Question: Summarize what this figure shows in one sentence.
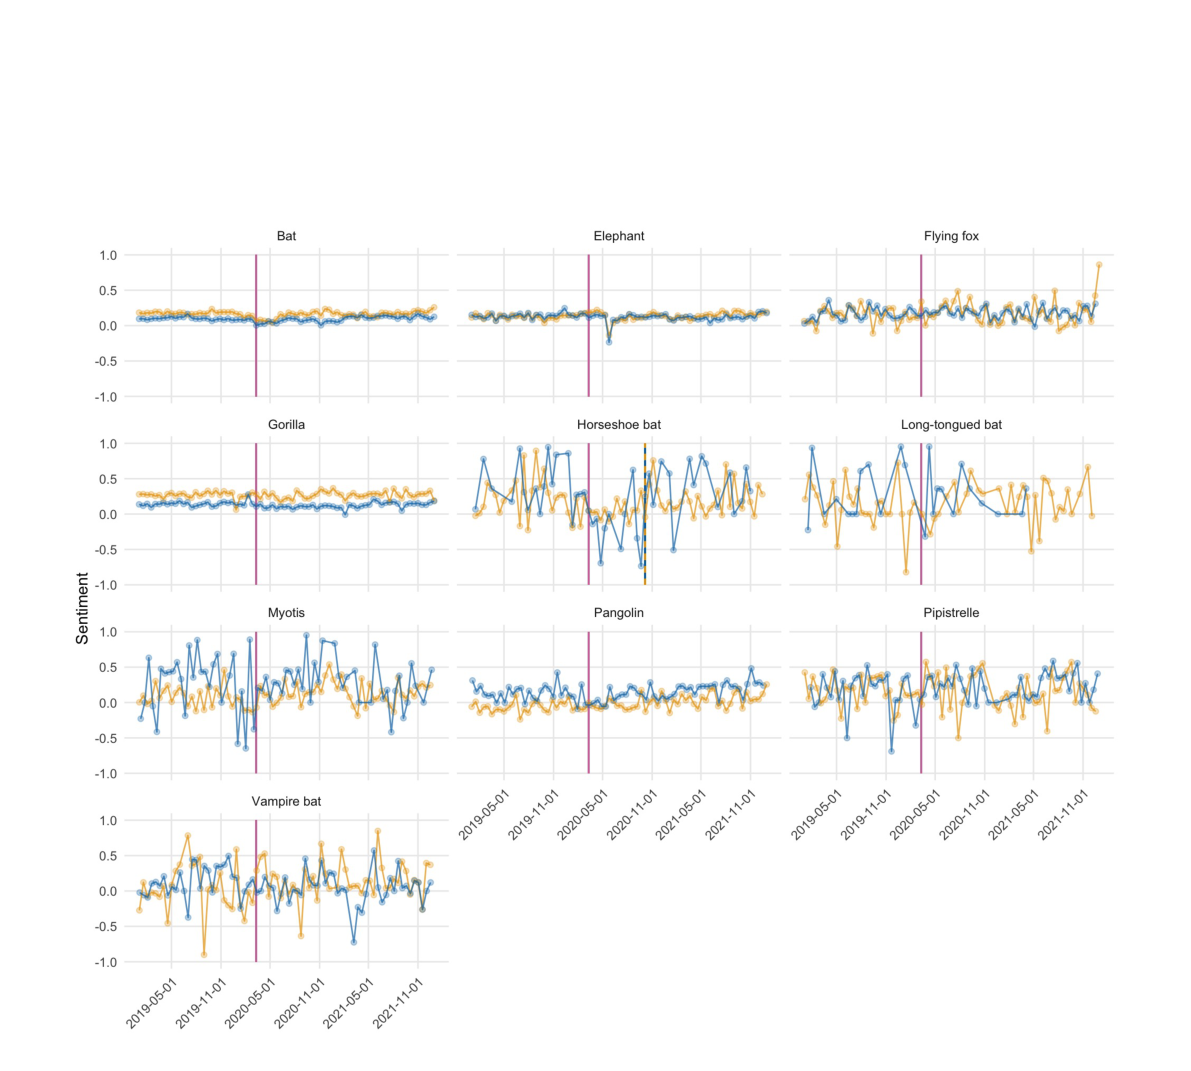
Answer: displays changes in mean article sentiment for all of the focal taxa analyzed in the pipeline.